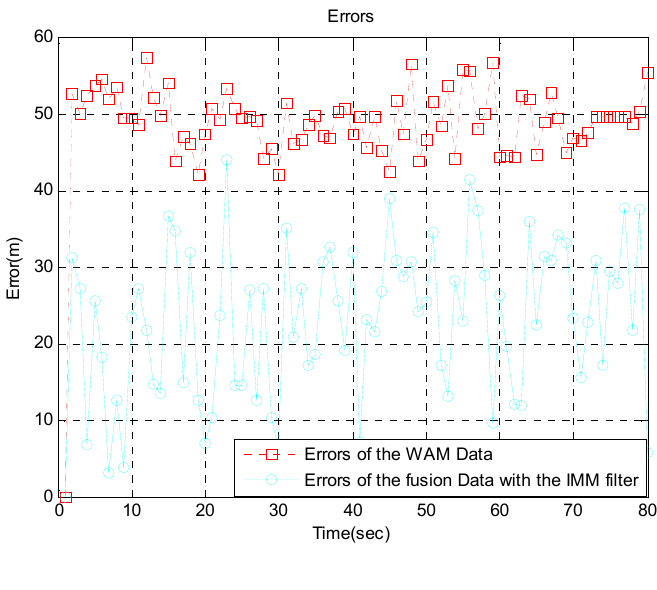
Figure 12. Errors between WAM data and fusion data with the IMM filter at 192 km from the